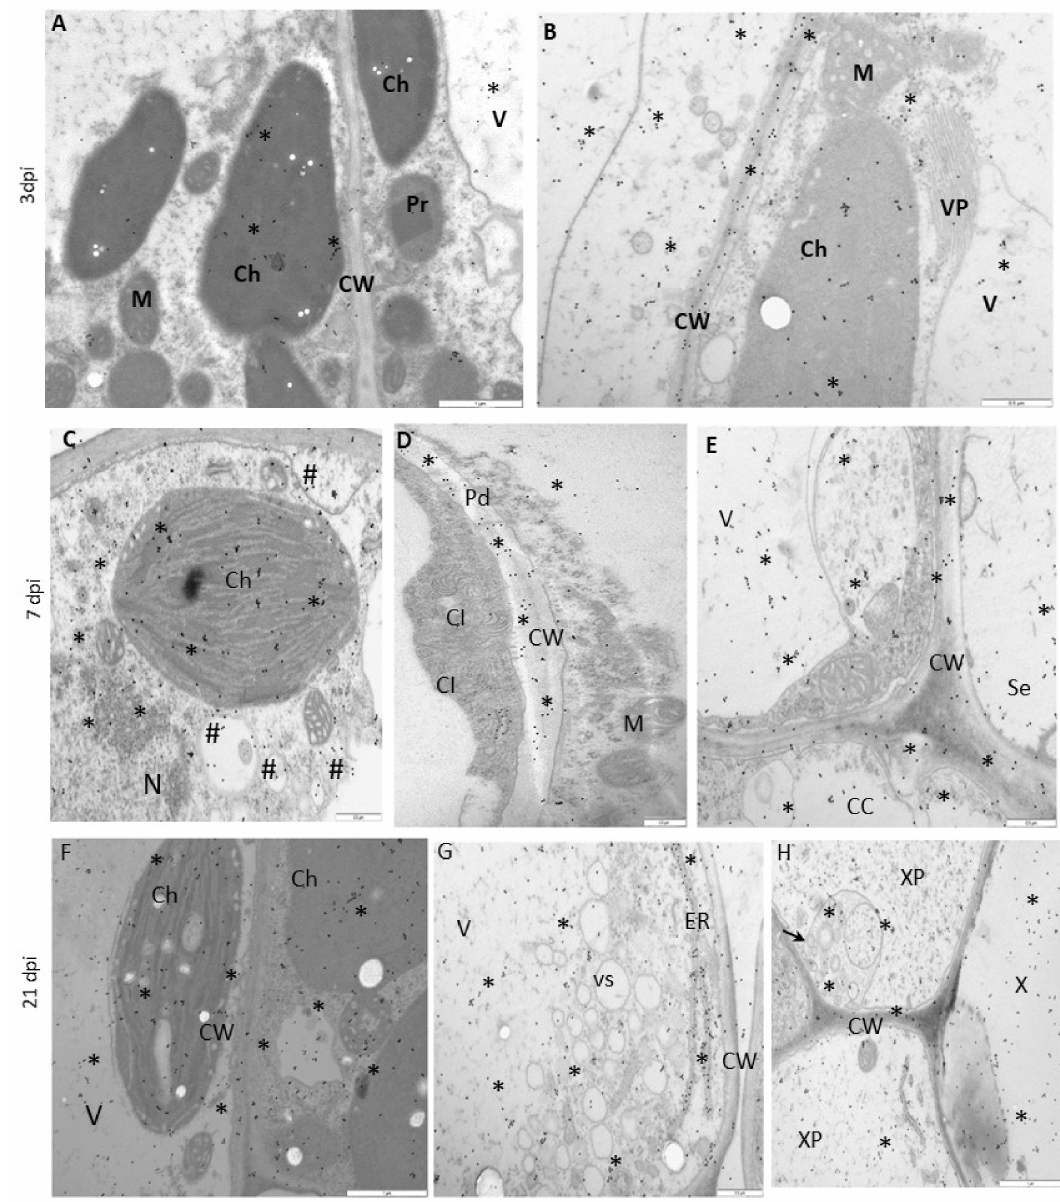
Figure 9. Immunogold localization of HSC70 in susceptible Irys leaves. ( A , B ) at 3 dpi, ( C , E ) at 7 dpi, ( F , H ) at 21 dpi. ( A ) HSC70 (*) in chloroplasts (Ch) and vacuoles (V) of mesophyll cells. Scale bar: 1 µ m. ( B ) HSC70 (*) in the cell wall and apoplast with vesicles. Gold granules in chloroplasts (Ch) around virus particles (VP) and inside vacuoles (V). Scale bar: 0.5 µ m. ( C ) HSC70 (*) in chloroplasts (Ch), nucleus (N), membranous and vesicular structures (#), and in the cytoplasm. Scale bar: 0.5 µ m. ( D ) HSC70 (*) in the cell wall (CW) within the plasmodesmata area (Pd) in mesophyll cells. Virus cytoplasmic inclusions (CI) in the cytoplasm. Scale bar: 0.5 µ m. ( E ) HSC70 (*) in the sieve element (Se) and companion cells (CC) of the phloem. Gold granules in the cell wall (CW), vacuoles (V), and vesicular and membranous structures. Scale bar: 0.5 µ m. ( F ) HSC70 (*) in chloroplasts (Ch), vacuoles (V), and the cytoplasm. Scale bar: 1 µ m. ( G ) HSC70 (*) inside and around vesicular structures (vs) and along the ER. Scale bar: 0.5 µ m. ( H ) HSC70 (*) in the xylem tracheary element (X) and the cytoplasm of xylem parenchyma cells (XP). Gold granules in multivesicular structures (arrow) and the cell wall (CW). Scale bar: 1 µ m. M—mitochondria,